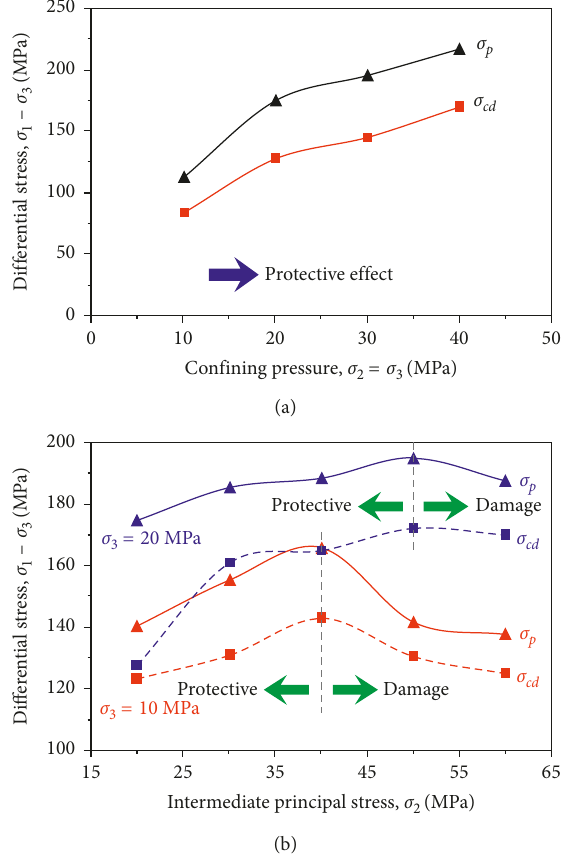
Figure 9: Variation rule of rock damage strength and peak strength under conventional triaxial and true triaxial